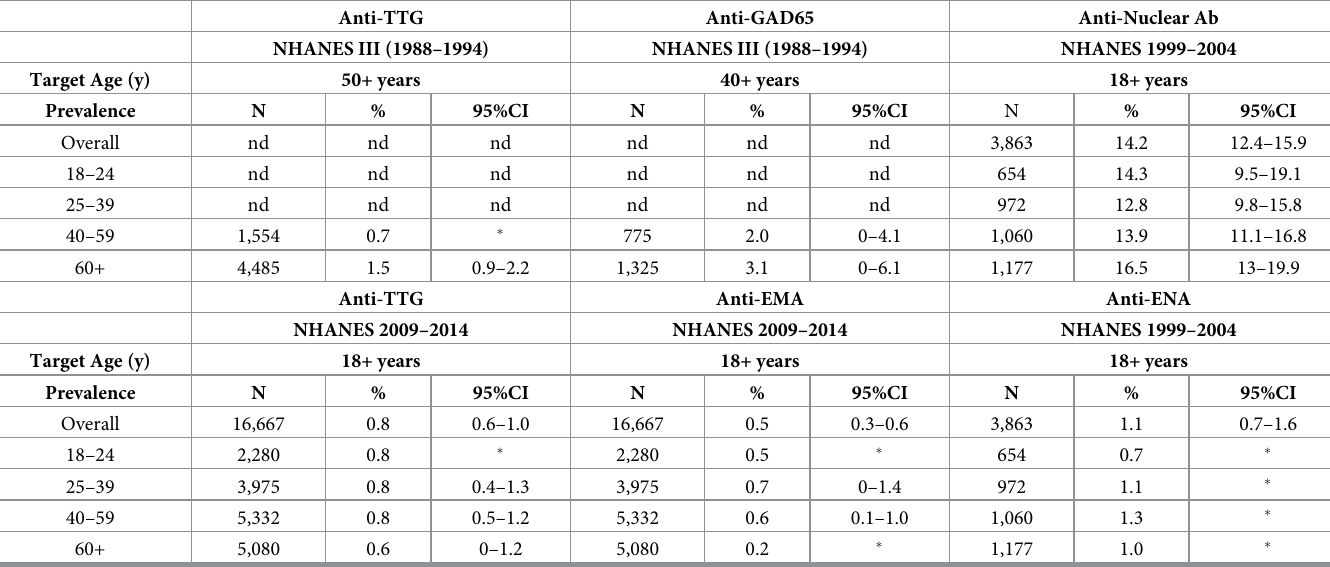
Table 3. US prevalence of celiac, diabetes and antinuclear autoantibodies,